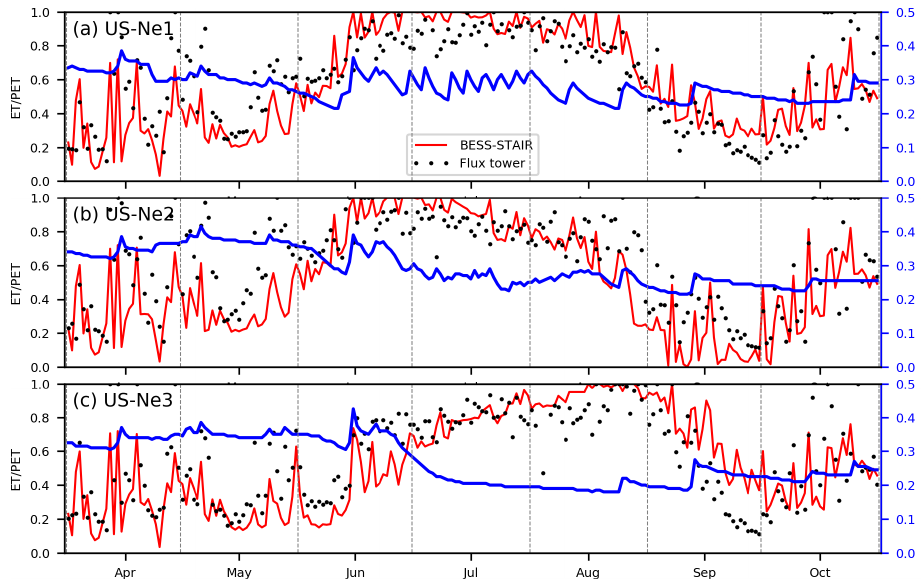
Figure 7. Seasonal time series of daily ET/PET derived from BESS-STAIR and the flux tower for US-Ne1, US-Ne2, and NS-Ne3 in 2012, along with measured daily mean soil water content (SWC).